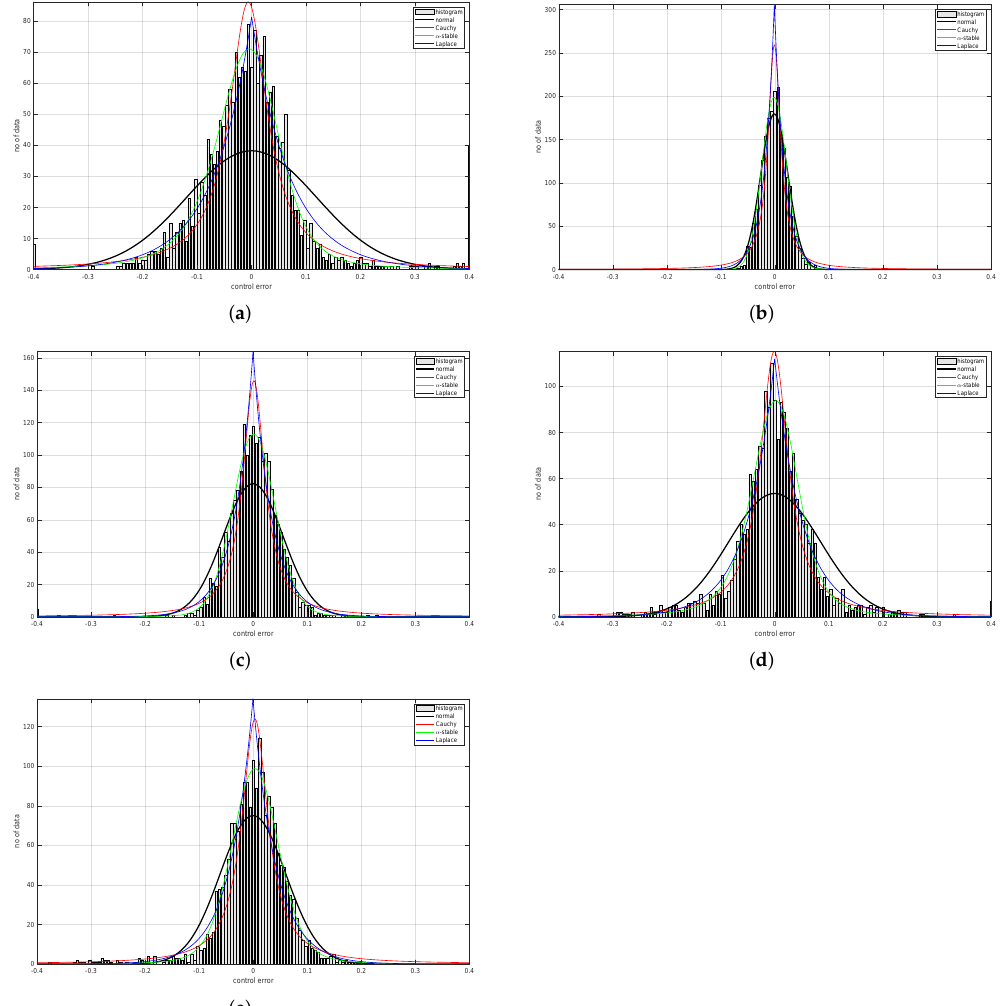
Figure 6. Control errors histograms for the simulation data impacted by the Gaussian noise with PDF fitting. ( a ) Control error (cid:101) 1 , ( b ) Control error (cid:101) 2 , ( c ) Control error (cid:101) 3 , ( d ) Control error (cid:101) 4 , ( e ) Control error (cid:101) 5